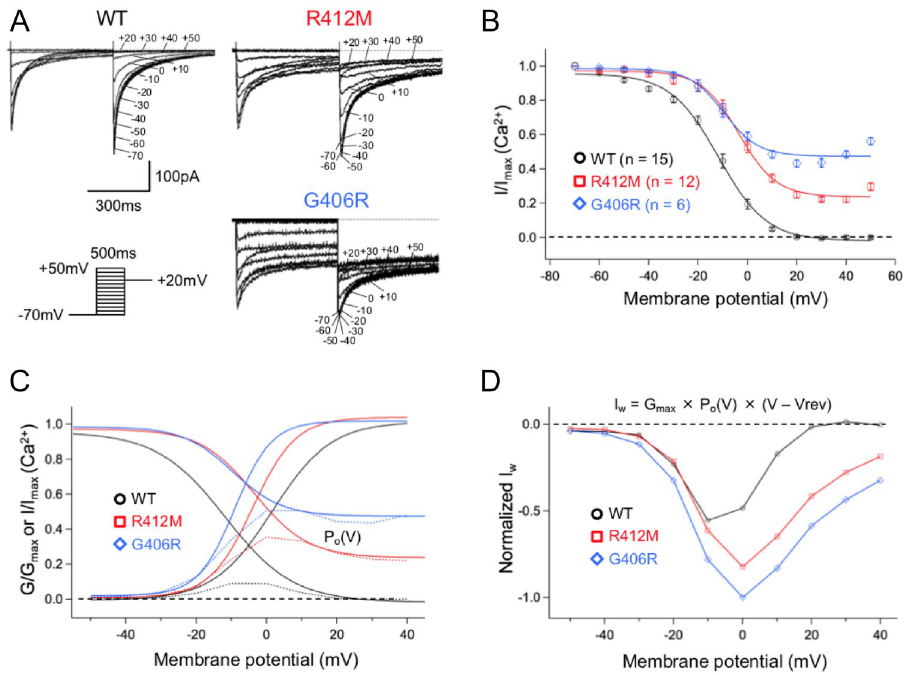
Figure 4. ( A ) Three sets of representative current traces for WT, R412M, and G406R I Ca elicited recorded by a double step pulse protocol in the inset. ( B ) inactivation voltage-dependence curves for WT (black circles, n = 15) and R412M (red squares, n = 12) and G406R (blue diamonds, n = 6) I Ca . ( C ) Both activation and inactivation curves are plotted on the same scale. The probability of channel opening P o (V) curves were obtained by multiplying G/G max by I/I max (dotted curves). ( D ) The window currents (I w ) calculated by multiplying P o (V) by G max and the driving force (V–V rev ) and were normalized by the maximum I w at 0 mV in G406R. V rev means reversal